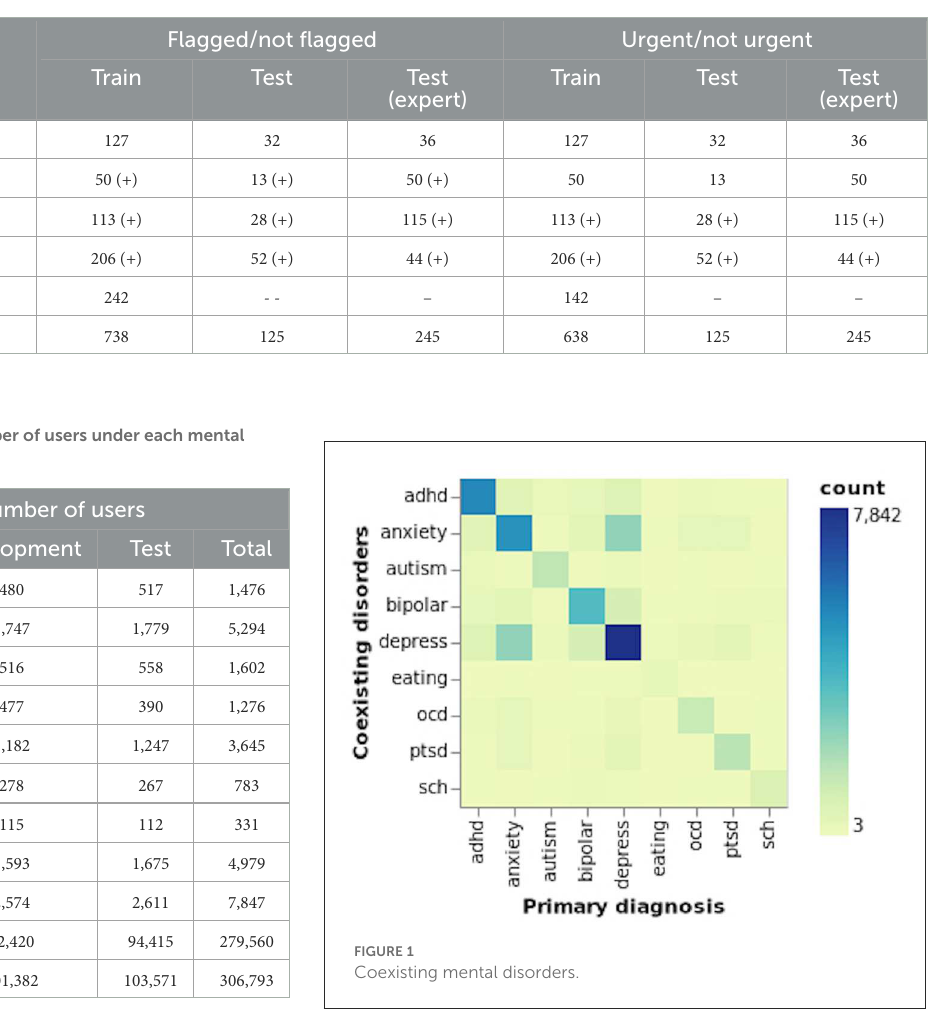
TABLE 3 UMD reddit suicidality dataset with detailed class distributions.